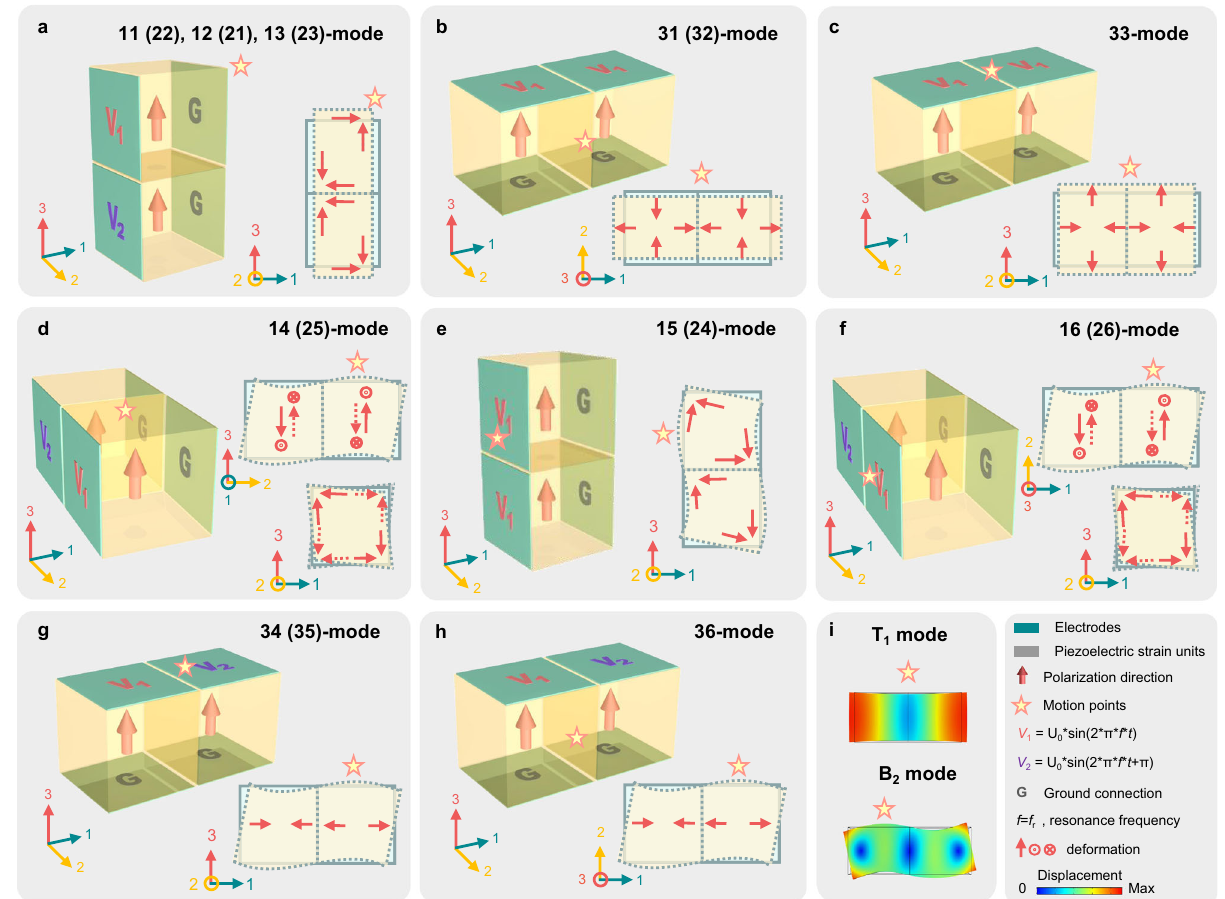
f arti fi cial 16 (26)-mode; g arti fi cial 34 (35)-mode; h arti fi cial 36-mode. i The simu- lated deformations diagrams of a – h